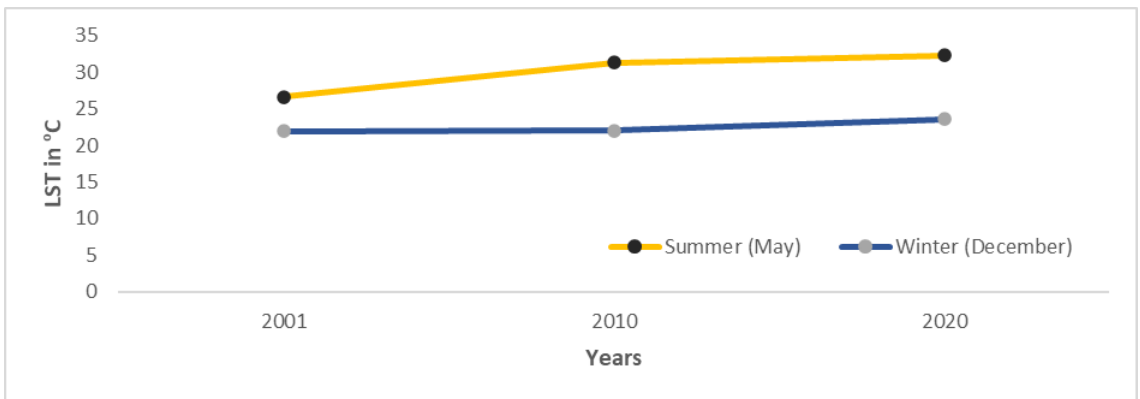
Figure 3. Trends in LST during 2001, 2010 and 2020 over the study area for summer (May) and winter (Dec.)